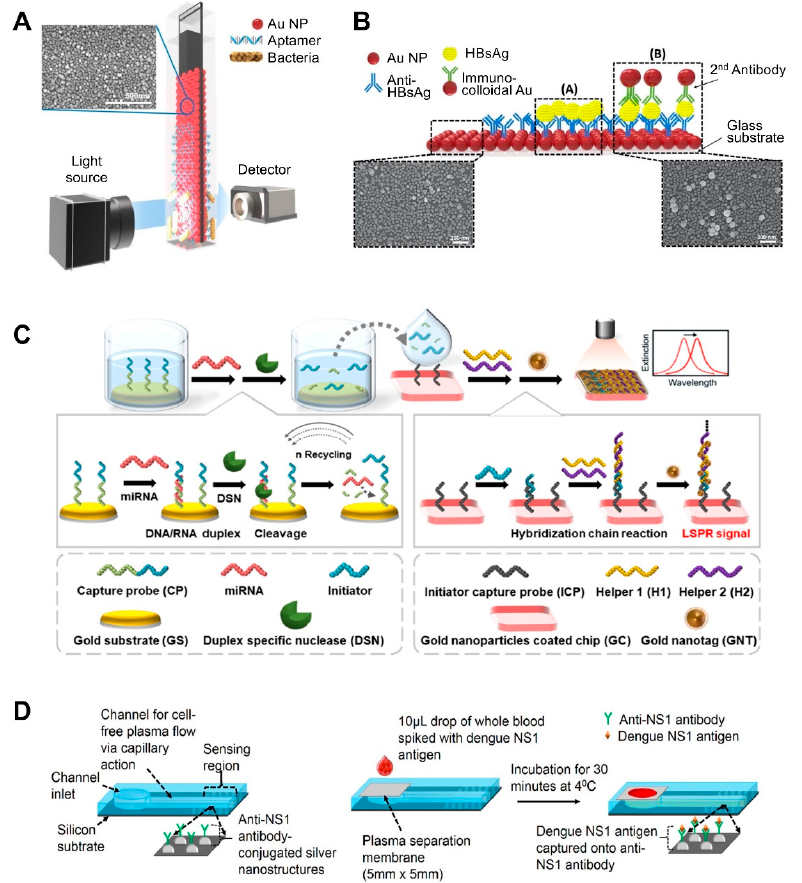
Figure 2. LSPR biosensing strategies based on nanoparticle (NP)-deposited flat substrates: ( A ) De- tection of bacterial cells using aptamer-functionalized Au-coated glass slides. Reproduced with permission from [57]; ( B ) Detection of hepatitis B surface antigen (HBsAg) using a heteroassembled sandwich structure on a glass slide consisting of antibody-conjugated AuNPs and anti-HBsAg-con- jugated AuNPs. Reproduced with permission from reference [59]; ( C ) Detection of miRNA using a duplex-specific nuclease-mediated target recycling reaction-coupled LSPR sensor on a Au substrate. Reproduced with permission from [63]; ( D ) Detection of the NS1 antigen of the dengue virus in whole blood using a silver NP-deposited silicon substrate functionalized with antibodies, which was coupled with a polyethersulfone membrane filter at the inlet of the biosensor for plasma sepa- ration. Reproduced with permission from [65]. Au nanorod (GNR) was also deposited on the glass and applied to detect various biomolecules [61,62]. To improve the LSPR signal of the GNR substrate, a signal enhancer molecule (i.e., berberine) was used for improving the LSPR signal shift [61]. Berberine makes the LSPR signal more red-shifted by intercalating itself into the G-quadruplex structure formed when the aptamer binds to the analyte and suffers a conformational change, resulting in enhanced sensitivity and broader dynamic range compared to ber- berine-free sensors. This sensor could detect OTA, aflatoxin B1, ATP, and K + at sensitivi- ties of 0.56, 0.63, 0.87, and 1.05 pM, respectively, accounting for a 1000-fold increase in the detection limit with a broad dynamic range of 10 pM to 10 μ M with linearity. As another means to improve the LSPR signal, the surface of the GNRs was functionalized with citrate